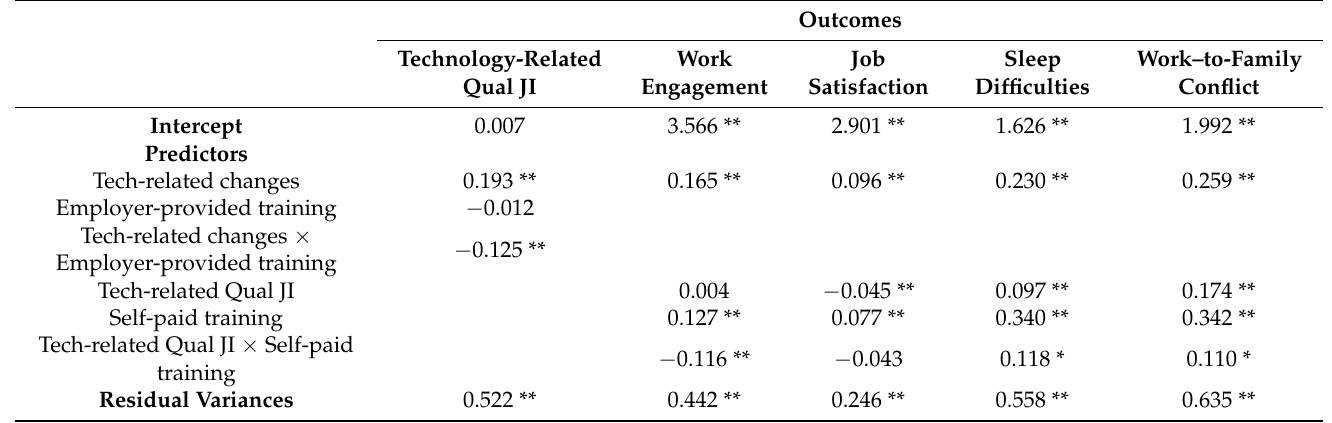
Table 3. Path analysis results for the hypothesized